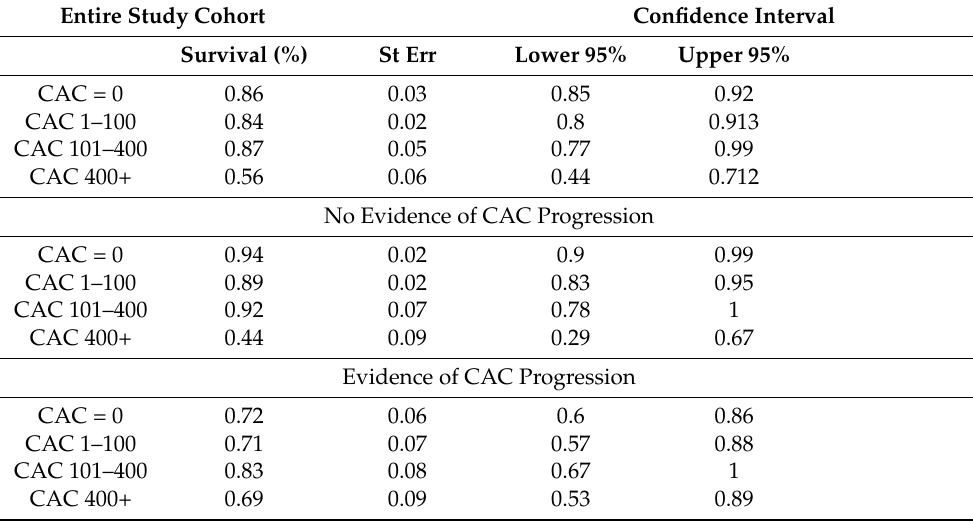
Table 4. Survival probability according to baseline coronary artery calcification (CAC) in the